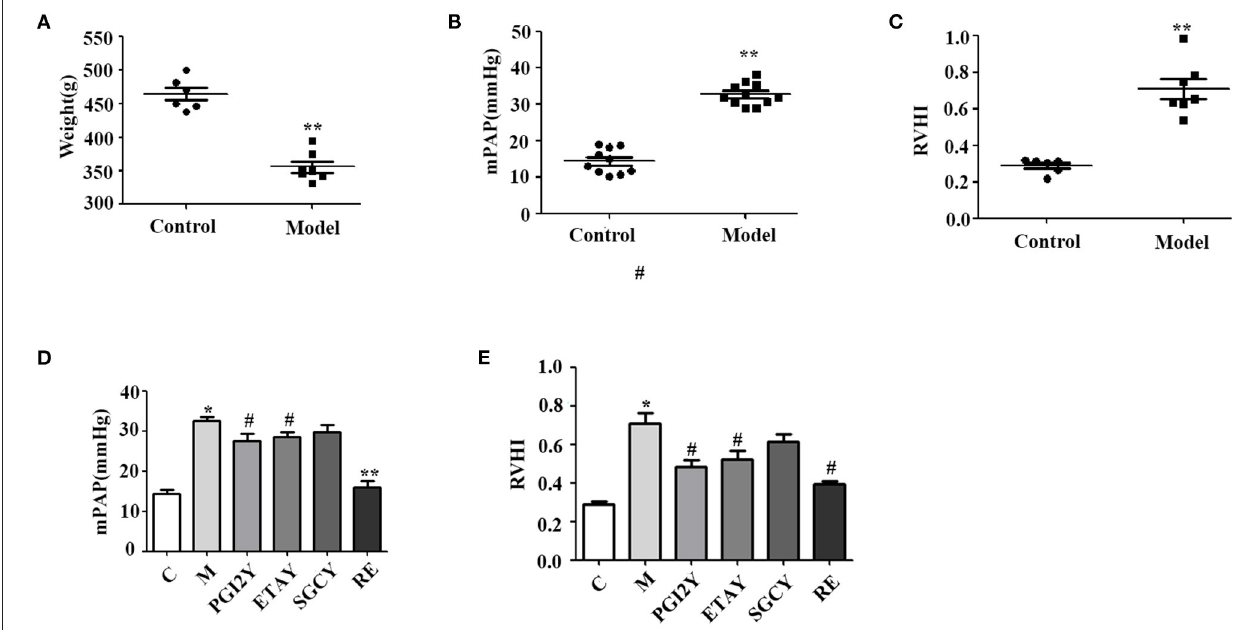
FIGURE 1 | Establishment of the high-altitude pulmonary hypertension (HAPH) rat model, and the effects of the targeted drugs and reoxygenation on high-altitude pulmonary hypertension. (A) Weight. (B) Mean pulmonary artery pressure (mPAP). (C) Right ventricular hypertrophy index: RVHI = RV/(LV + IVS). (D) mPAP and (E) RVHI after treatment. C, control; M, model group; PGI2Y, selexipag treatment group; ETAY, macitentan treatment group; SGCY, riociguat treatment group; RE, reoxygenation group. Data represent mean ± SD. Student’s t -tests: * P < 0.05 vs. control, # P < 0.05 vs. M; ** P < 0.0001 vs.